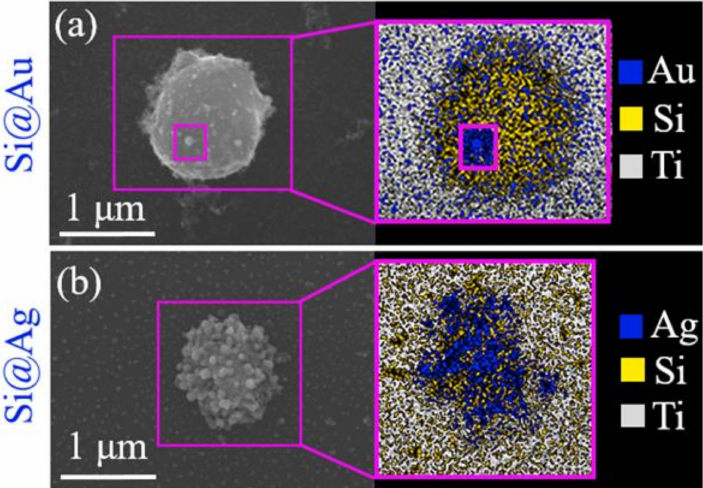
Figure 11. Dry deposits of Au/Si ( a ) and Ag/Si ( b ) NPs on a Si substrate: SEM images (left) and the corresponding elemental analysis by EDX spectroscopy (right) (adapted from